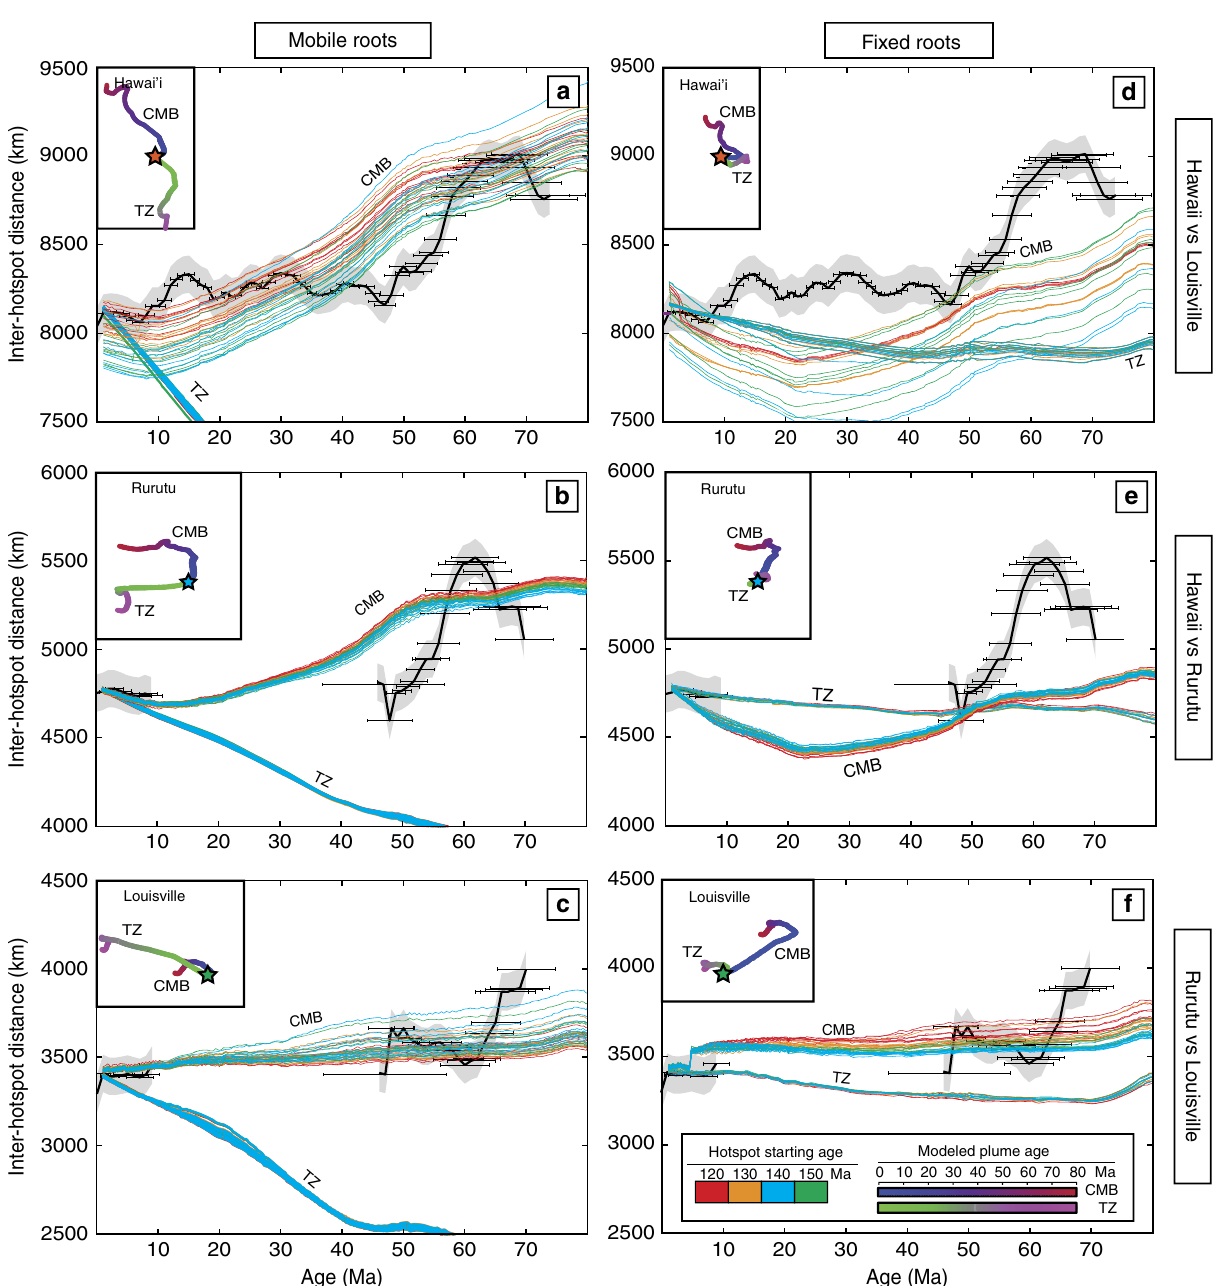
Fig. 2 The observed relative inter-hotspot distances through time compared against modeled simulations. The relative motions are from Fig. 1 compared with plume motion model results (colored lines) for both plumes rooted in the D ″ above the core mantle boundary (CMB) and at a depth of 660 km at the base of the transition zone (TZ). Black lines and gray uncertainty bounds are the measured inter-hotspot distances as shown in Fig. 1. Individual colored lines represent different buoyancy fl uxes (1 – 9×10 3 kg/s) and each line color represents a different starting age of the compared hotspot (from 120 to 150 Ma) with the scale shown in the bottom right. The mantle viscosity model used here is from Steinberger and Calderwood 56 and the tomography model used is TOPOS362d1 69 . The starting age for Hawaii is 130 Ma with a buoyancy of 5×10 3 kg/s in panels a , b and d , e with variable Louisville and Rurutu ages and buoyancy, while it is 120 Ma and a buoyancy of 5×10 3 kg/s for Louisville in panels c and f with Hawaii and Rurutu being varied. a Hawaii compared against Louisville with mobile roots. b Hawaii compared against Rurutu with mobile roots. c Rurutu compared against Louisville with mobile roots. d Hawaii compared against Louisville with fi xed roots. e Hawaii compared against Rurutu with fi xed roots. f Rurutu compared against Louisville with fi xed roots. Example model results for CMB (red-blue) and TZ (pink-green) hotspot locations through time with a starting age of 150 Ma (Hawaii and Rurutu) and 120 Ma (Louisville) and buoyancy fl uxes of 5×10 3 kg/s (Hawaii and Rurutu) and 3×10 3 kg/s (Louisville) are shown as insets in each feature and thus cannot be easily calibrated against our new 40 Ar/ 39 Ar geochronological data from the Rurutu hotspot chain and the observed changes in inter-hotspot distance between Hawaii, Louisville, and Rurutu over the last 70 Myrs.